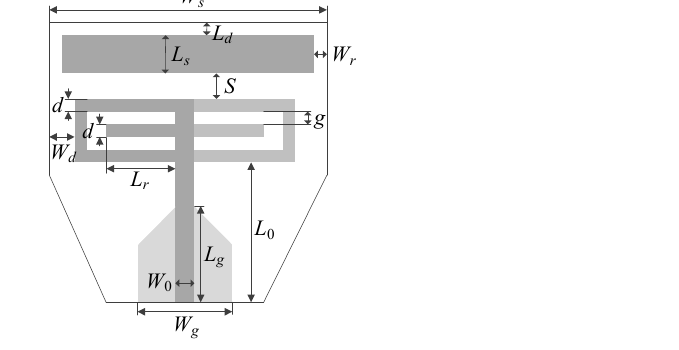
Figure 6. Dual-band dipole antenna geometry [55]. Ground plane shown using the light-gray shade.